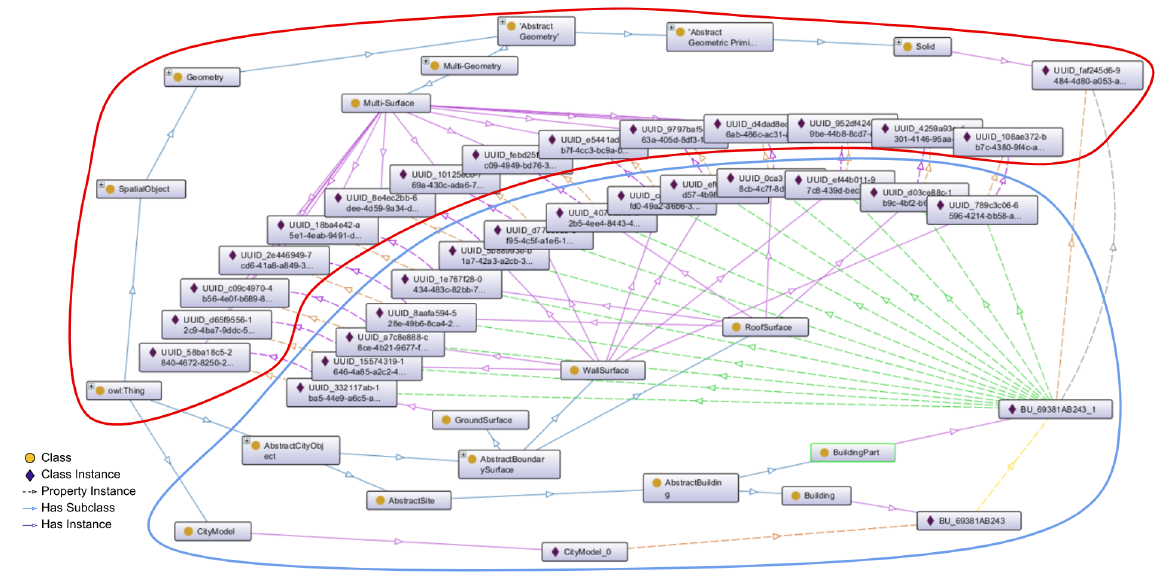
Figure 6. RDF Graph of classes and instances concerning building data generated according to the 4D Urban Data Semantic model defined in Figure 1; CityGML 3.0 Building data is circled in blue; GML geospatial data is circled in red; dashed arrows represent instances of semantic properties (or